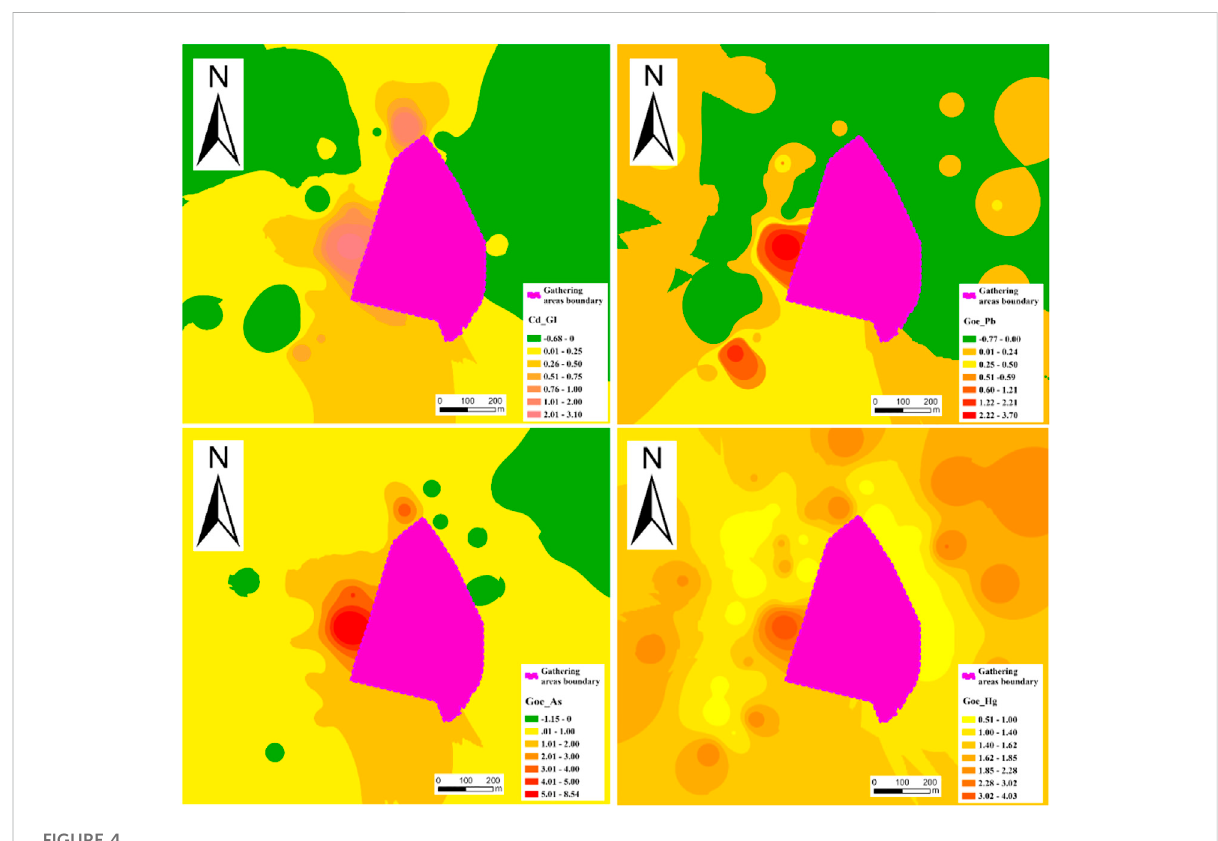
FIGURE 4 Spatial distribution of geo-accumulation